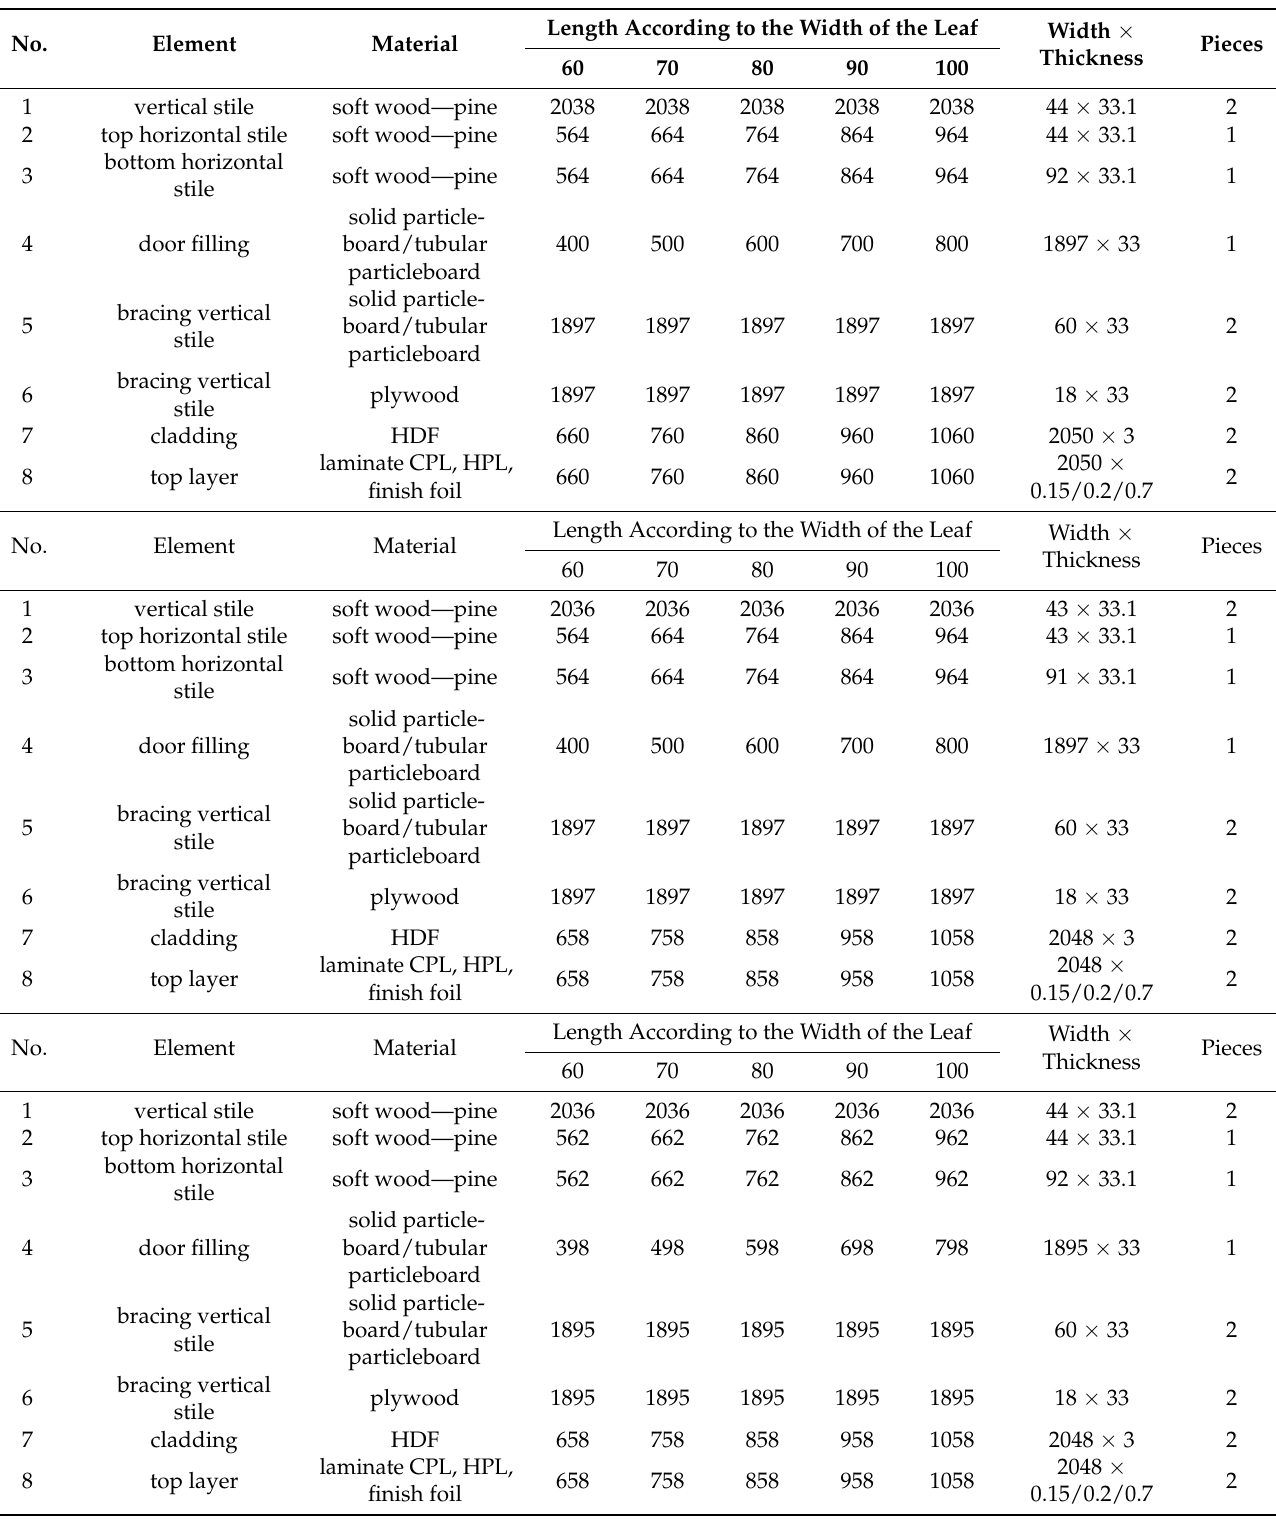
Table 2. Construction 2. Previously used values of machining allowances; reduced machining allowances, variant 1;